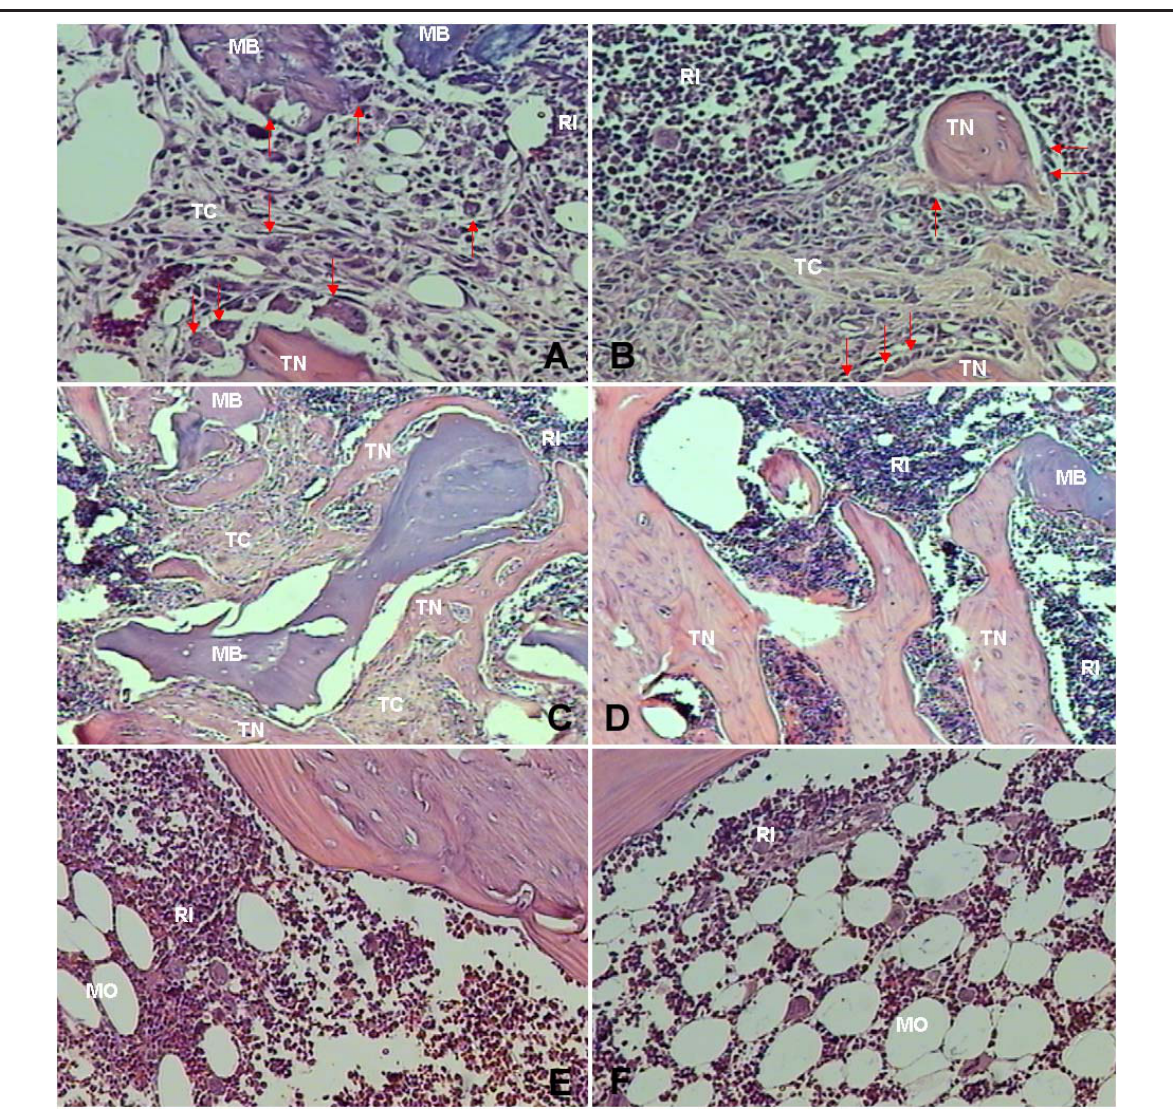
FIGURA 1 – Fotomicrografias da área do defeito padrão (HE-100x). A: 7 dias de seguimento, sem calcitonina, mostrando fragmentos de matriz óssea bovina (MB), reação inflamatória (RI), tecido conjuntivo (TC), trabéculas ósseas neoformadas (TN) e células gigantes multinucleadas (setas) em contato com a matriz óssea bovina e dispersas no infiltrado inflamatório. B: 7 dias de seguimento, com calcitonina, mostrando reação inflamatória, tecido conjuntivo rico em osteoblastos (setas) e trabéculas ósseas neoformadas. C: 14 dias de seguimento, sem calcitonina, mostrando fragmentos de matriz óssea bovina, reação inflamatória, tecido conjuntivo e delgadas trabéculas de osso neoformado. D: 14 dias de seguimento, com calcitonina, fragmentos de matriz óssea bovina, reação inflamatória, tecido conjuntivo e espessas e bem organizadas trabéculas de osso neoformado. E: 21 dias de seguimento, sem calcitonina, mostrando formação incompleta da medular óssea e presença de reação inflamatória. F: 21 dias de seguimento, com calcitonina, mostrando formação completa da medular óssea e presença de reação